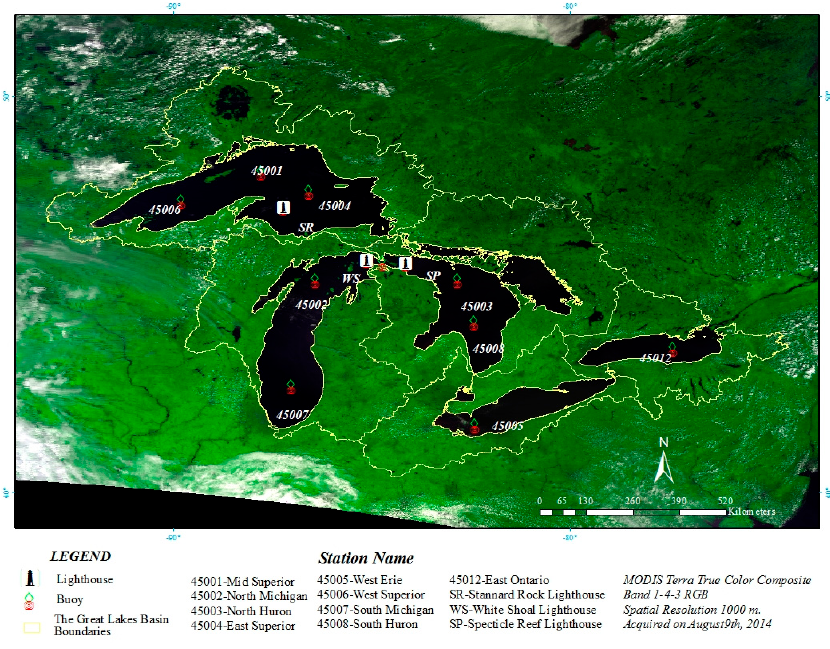
Figure 1. The Great Lakes basin boundaries and geographic locations for water surface temperature